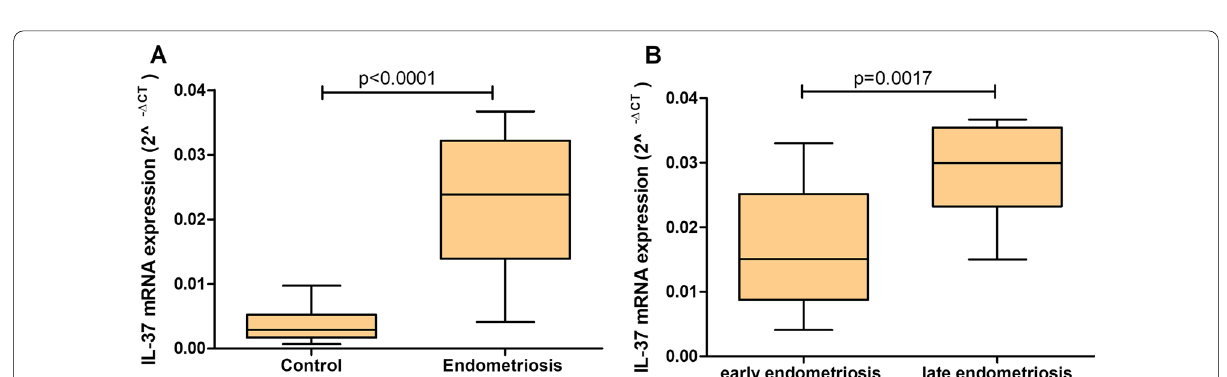
Fig. 3 Higher relative expression of IL-37 mRNA in endometriosis patients compared to control females ( A ) and in late stages of endometriosis compared to early stages ( B